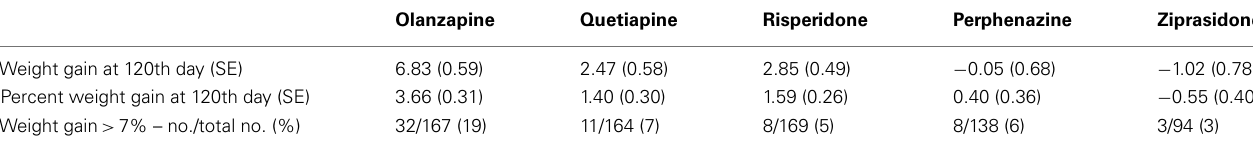
Table 4B |Weight measures after adjusting for covariates (Model 2: weight gain was estimated separately for each